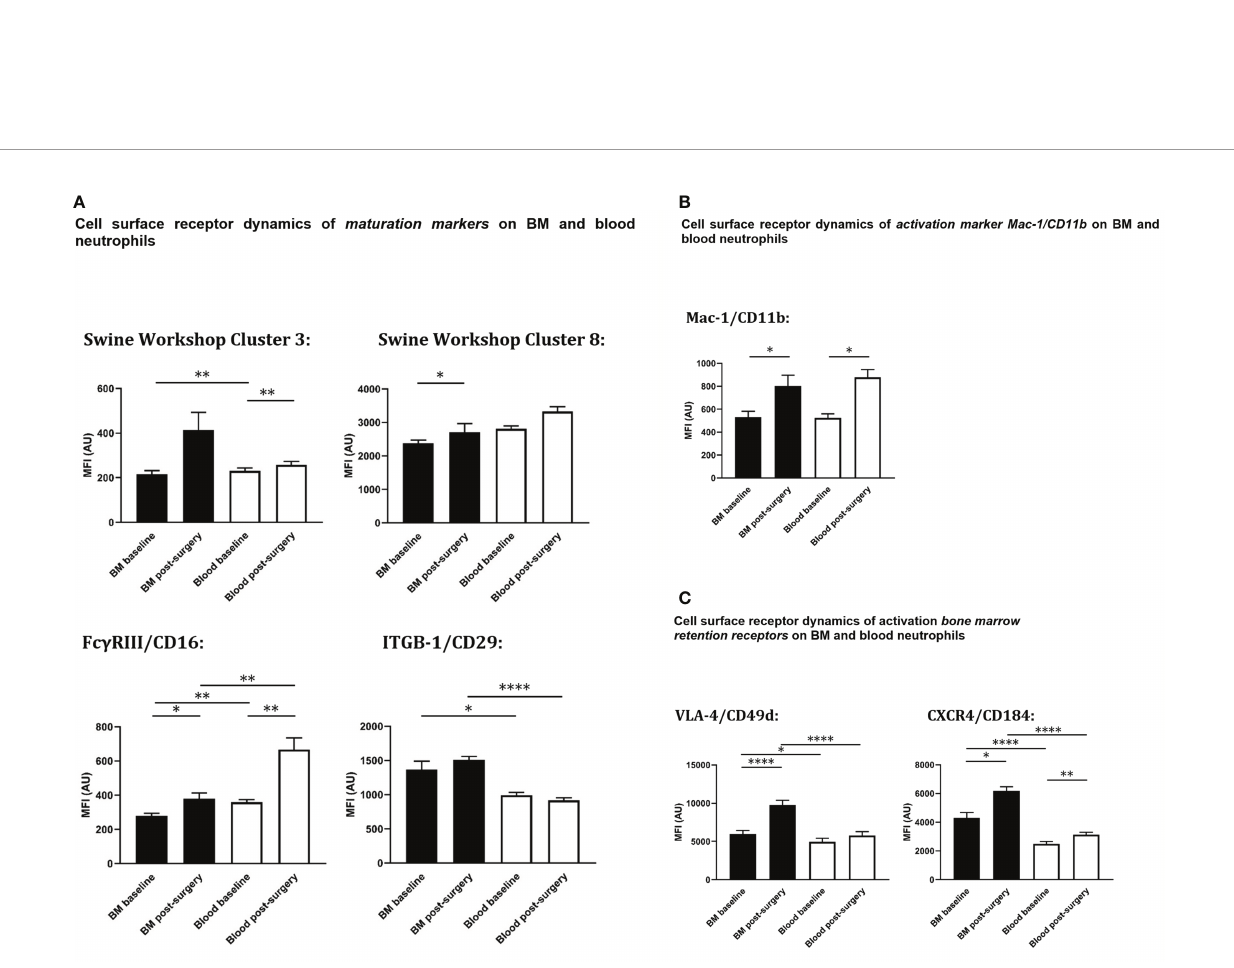
FIGURE 5 | Cell surface expression on circulating and bone marrow neutrophils at baseline and after extensive surgery. (A) BM-maturation markers, (B) activation markers, (C) BM retention receptors. Black bars represent bone marrow samples, white bars represent blood samples. Baseline samples were taken prior to intervention and termination sampling was performed directly after the fi nal procedure. Data are presented as mean ± SEM, MFI, median fl uorescence intensity in arbitrary units. *P < 0.05; **P < 0.01; ****P <